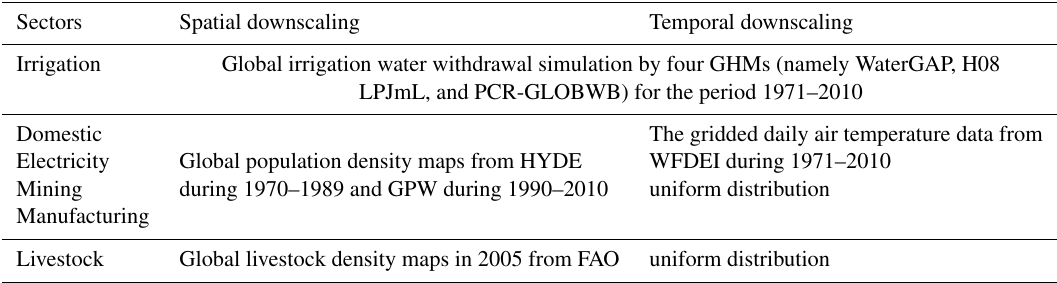
Table 1. Datasets for spatial and temporal downscaling of reported water withdrawal by